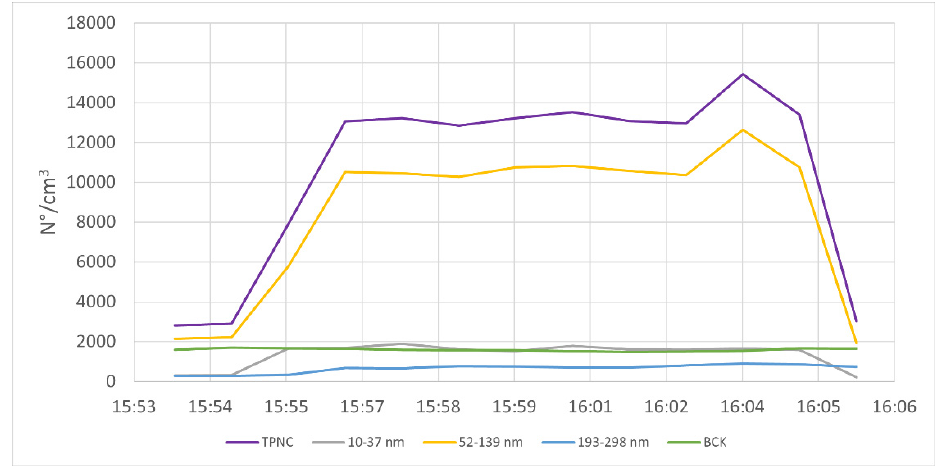
Figure 7. TPNC trends and the main particle size classes for O6–depowdering of the final product with compressed air in the post-process restricted area.